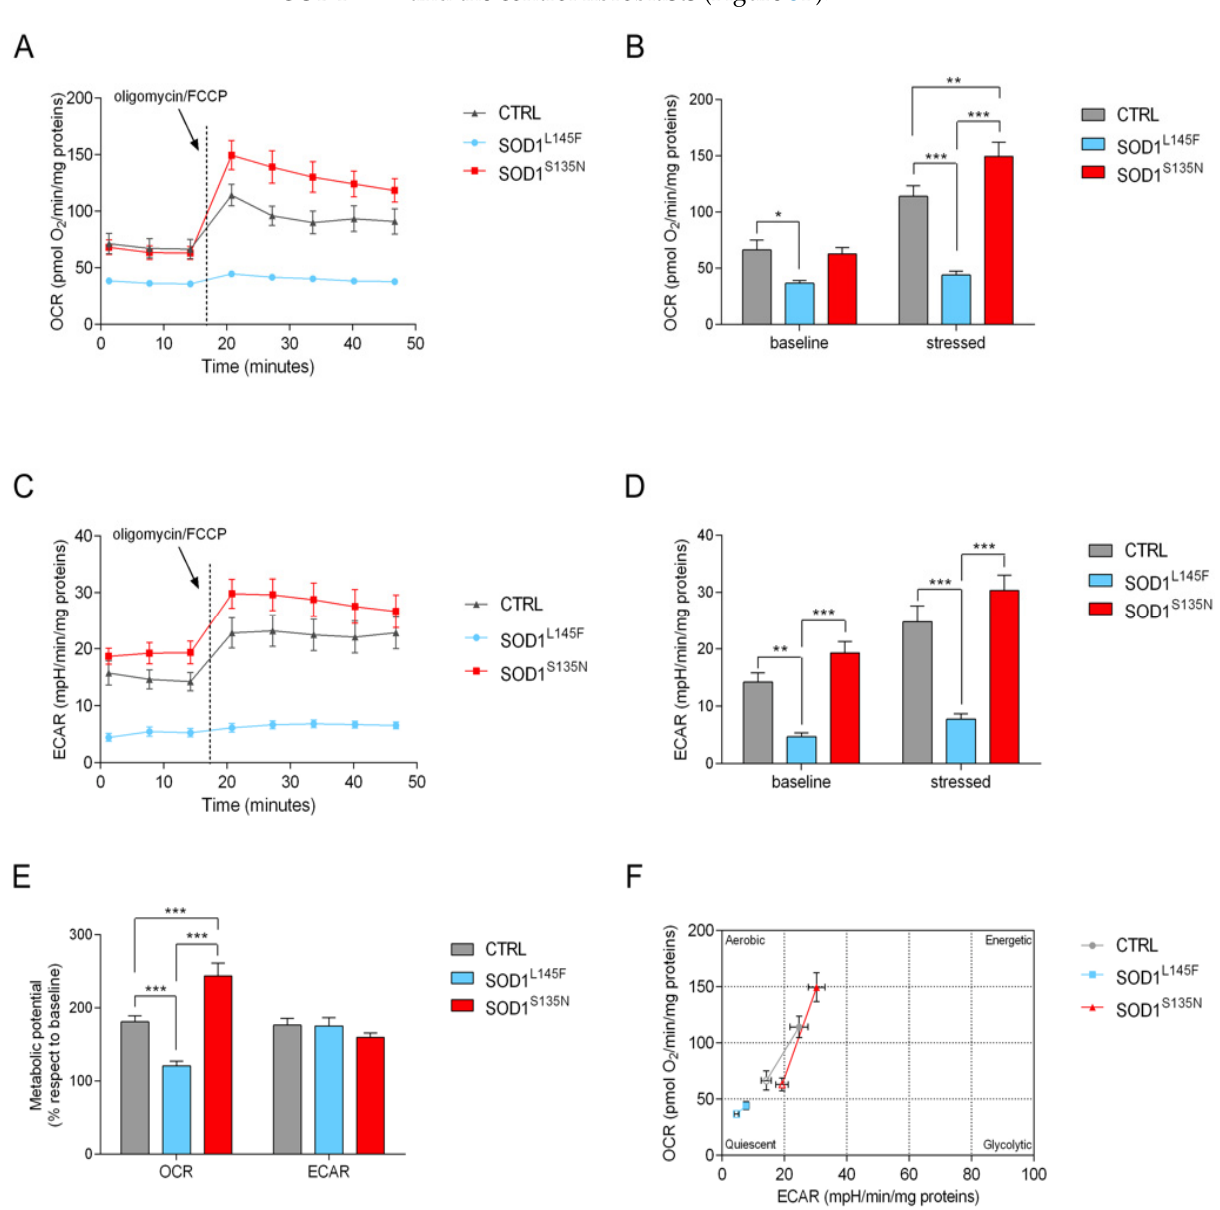
Figure 5. Cell energy phenotype evaluation. Representative OCR ( A ) and ECAR ( C ) profiles, expressed as pmol O 2 /min/mg proteins and mpH/ min/mg proteins in the control and SOD1 mutant cells, respectively. The arrows indicate the time of the simultaneous addition of oligomycin/FCCP. Baseline and stressed level of mitochondrial respiration ( B ) glycolysis ( D ) and metabolic potential. ( E ) Energetic panel of control and SOD1 mutants; open symbols represent baseline conditions and closed symbols the stressed ones ( F ). Bars indicate the mean ± SEM of at least three biological replicates. Statistical significance: * p < 0.05, ** p < 0.01 and *** p < 0.001.